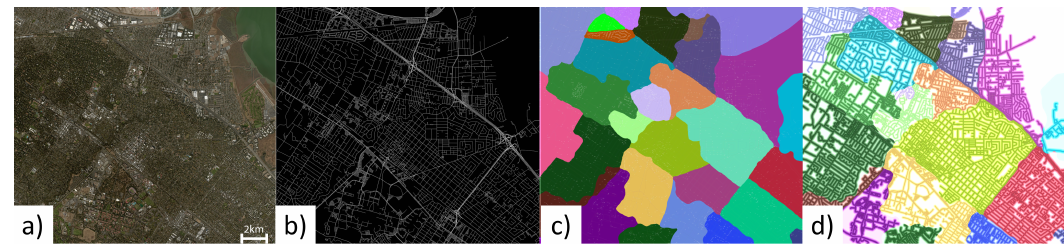
Figure 1. Generative Street Addresses. Our approach starts with ( a ) satellite imagery; predicts ( b ) roads; breaks them into ( c ) regions; to obtain ( d )